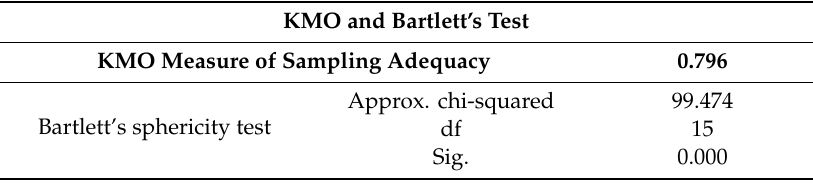
Table 3. Confirmatory factor analysis.